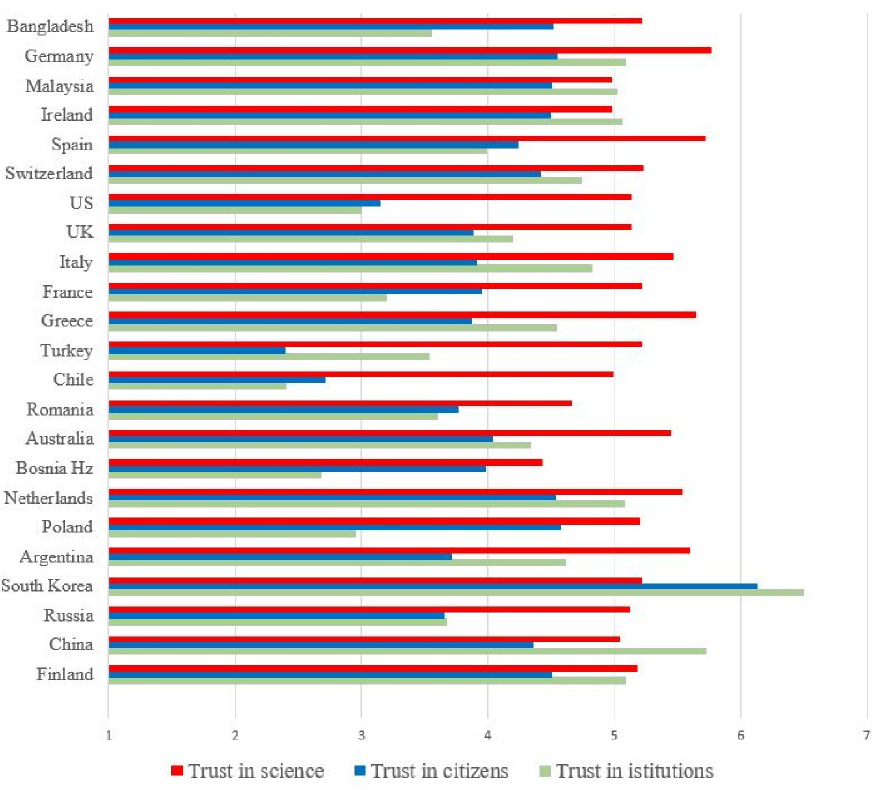
Fig 2. Mean levels of trust in science, citizens and government by country.